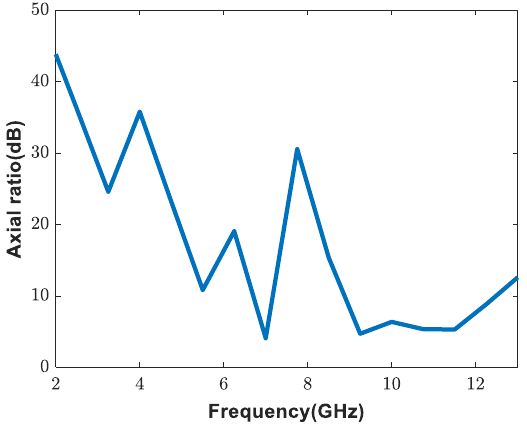
Figure 11. Simulated axial ratio of the proposed antenna.